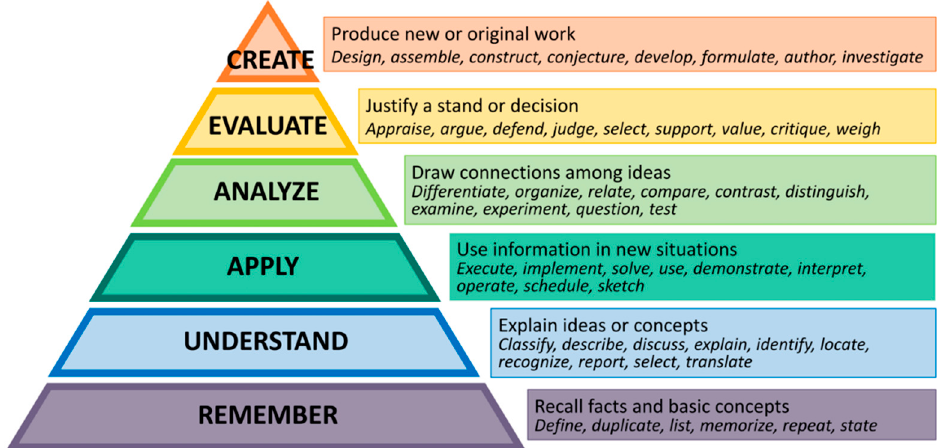
Figure 1. Bloom’s Taxonomy adopted from the Vanderbilt University Center for Teaching.